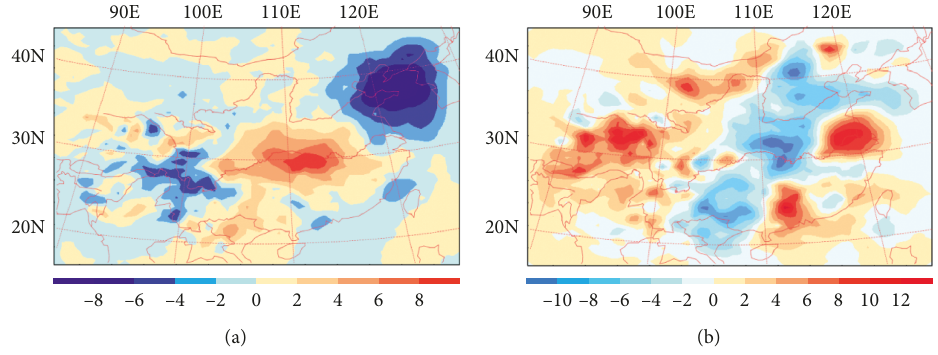
Figure 8: Sea surface pressure (Pa) changes caused by BC aerosols. (a) Summer. (b)